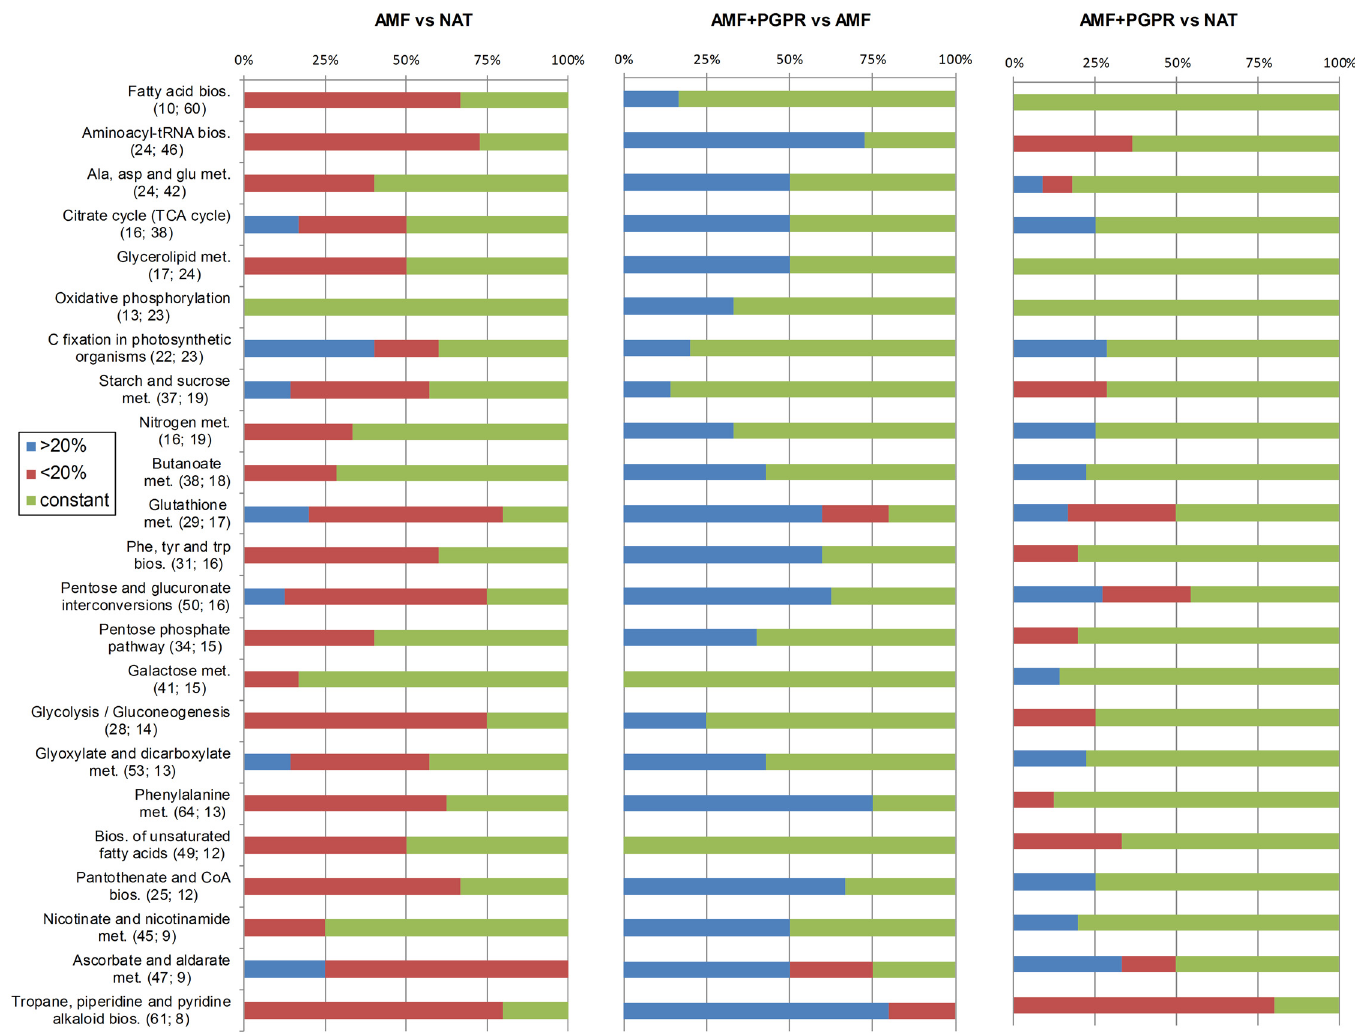
Fig 4. The percentage of annotated compounds included in Pathos in each metabolic pathway. Compounds are displayed as unchanged (green bars), or significantly increased (blue bars), or significantly decreased (red bars) at 20% minimum variation. The first number in parentheses indicates the total number of annotated compounds in the pathway, and the second number indicates the percentage of annotated compounds from the present data set in each metabolic pathway. Only those pathways that were significantly annotated in MBRole are